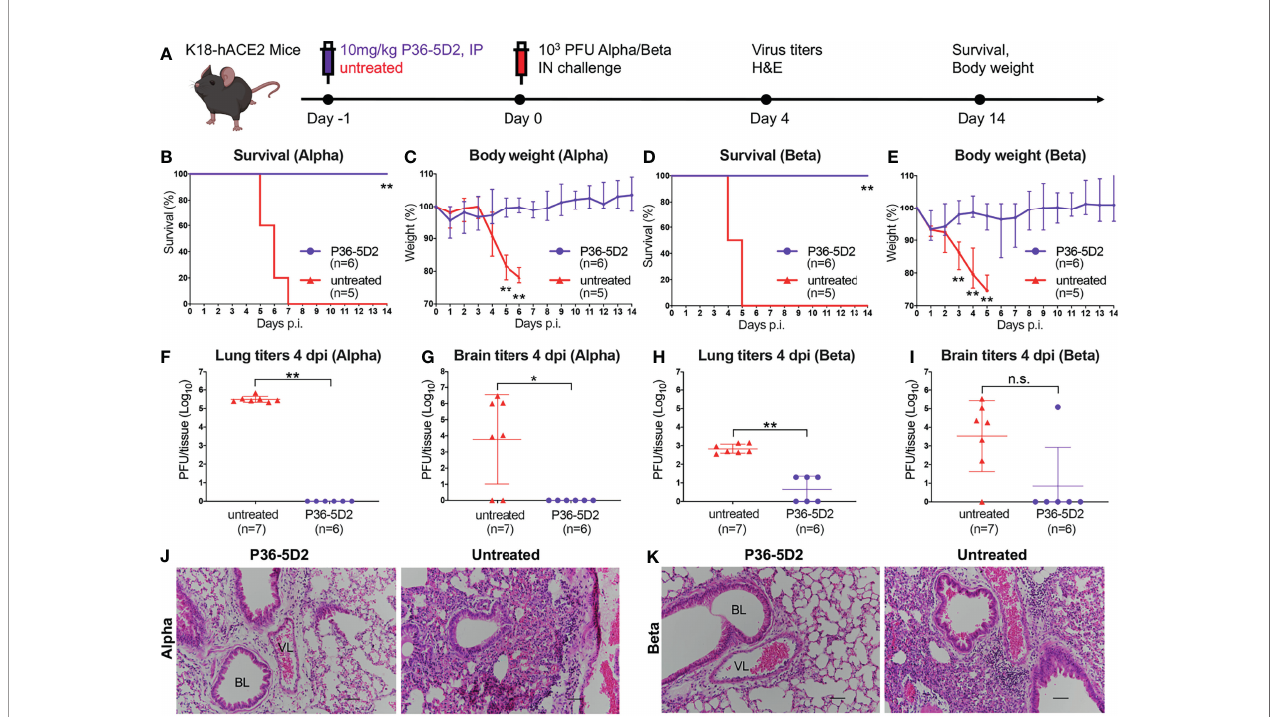
FIGURE 4 | Ef fi cacy of P36-5D2 prophylaxis against the infectious severe acute respiratory syndrome coronavirus 2 (SARS-CoV-2) Alpha or Beta variant in K18-hACE-2 mice. (A) Experimental schedule for antibody prophylaxis. Eight-week-old K18-hACE2 transgenic female mice were administered 10 mg/kg of P36- 5D2 intraperitoneally or untreated 1 day prior to challenge with 10 3 plaque-forming units (PFU) infectious SARS-CoV-2 Alpha or Beta via the intranasal route. (B – E) The survival percentage (B, D) and body weight (C, E) were recorded daily after infection until the occurrence of death or until the experimental end point at 14 days post-infection (dpi) (P36-5D2, n = 6; untreated, n = 5). Mice were sacri fi ced at 4 dpi for virus titer analysis (P36-5D2, n = 6; untreated, n = 7). (F – I) Lung titers (F, H) and brain titers (G, I) were tested by plaque assays in lung and brain tissue homogenates. The PFU per tissue were compared between groups in log 10 -transformed units. All data are presented as the mean ± SEM. Analysis of a two-tailed unpaired t- test was used. * p < 0.05, ** p < 0.01. n.s. , not signi fi cant. (J, K) H&E staining of lung sections from P36-5D2-injected or untreated mice at 4 dpi. VL , vascular lumen; BL , bronchiolar lumen. Scale bars , 50 mm. Each image is representative of each